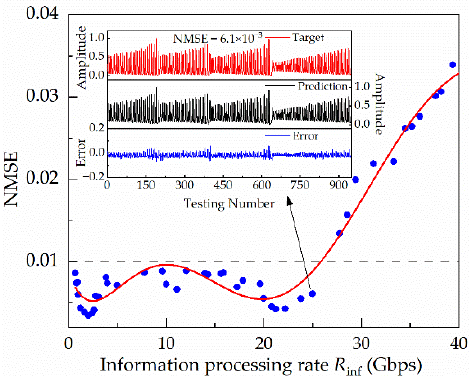
Figure 7. The system operation effect under different information processing rates R inf . The illustration is the target value ӯ (i) (red curve), predicted value y (i) (black curve) and error ( ӯ (i)- y (i)) (blue curve) of the Santa-Fe chaotic time series prediction task with under the R inf is 25 Gbps, with I = 12 I th , κ inj = 0.6, κ f = 1%, Δ ν = − 25 GHz and M = 25.